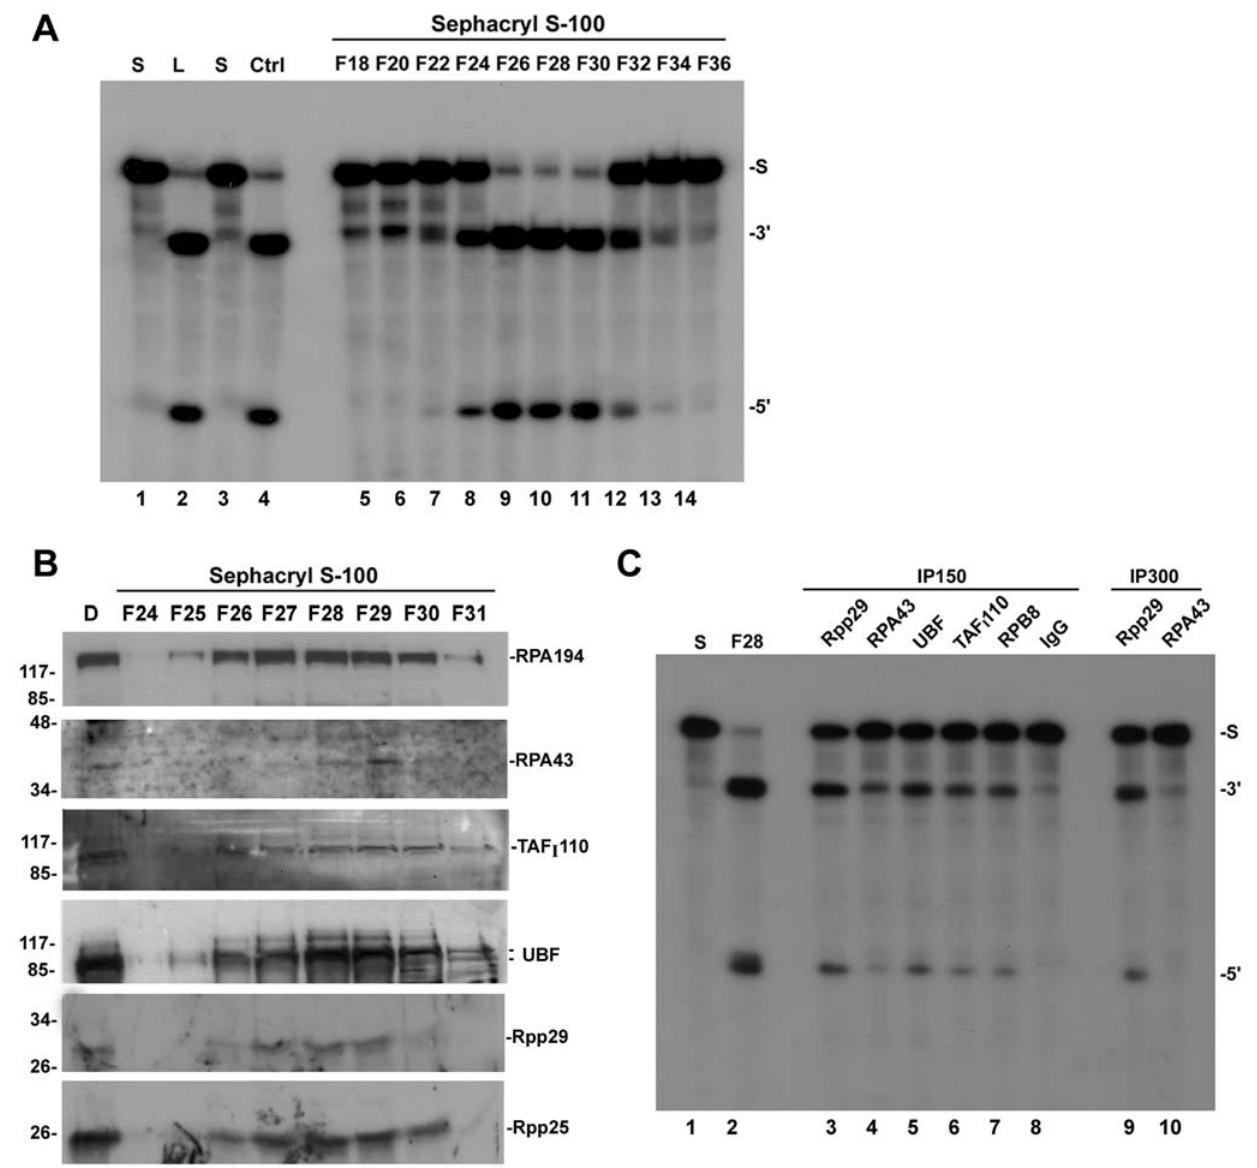
Figure 5. Pol I components copurify and associate with human RNase P. A. A DEAE-purified RNase P was loaded (L, load) into a Sephacryl S- 100 gel filtration column and eluted fractions were assayed for RNase P activity in processing of 32 P-labeled precursor tRNA Tyr (S) to mature tRNA (3 9 ) and 5 9 leader sequence (5 9 ). Substrate cleavage was analyzed as in Figure 4C with control HeLa RNase P (Ctrl). B. Western blot analysis of Sephacryl S- 100 eluted fractions using antibodies against RPA194, RPA43, TAF I 110, UBF, Rpp29 and Rpp25. Preparations of DEAE-purified RNase P (first lane) was used as control for input. Proteins were separated in 12% SDS/PAGE and the positions of the corresponding proteins and the protein size markers are shown. C. Fraction F28 described in A was subjected to immunoprecipitation analysis using antibodies against Rpp29 (lane 3), RPA43 (lane 4), UBF (lane 5), TAF I 110 (lane 6), RPB8 (lane 7) and IgG (lane 8) in the presence of 150 mM KCl (IP150). For Rpp29 and RPA43 immunoprecipitation was also performed at 300 mM KCl (lanes 9 and 10). Immunoprecipitates obtained were tested for RNase P activity in processing of a 32 P-labeled precursor tRNA Tyr (S). RNase P in fraction F28 was tested as control for enzyme activity (lane 2) and cleavage products were analyzed as in A.